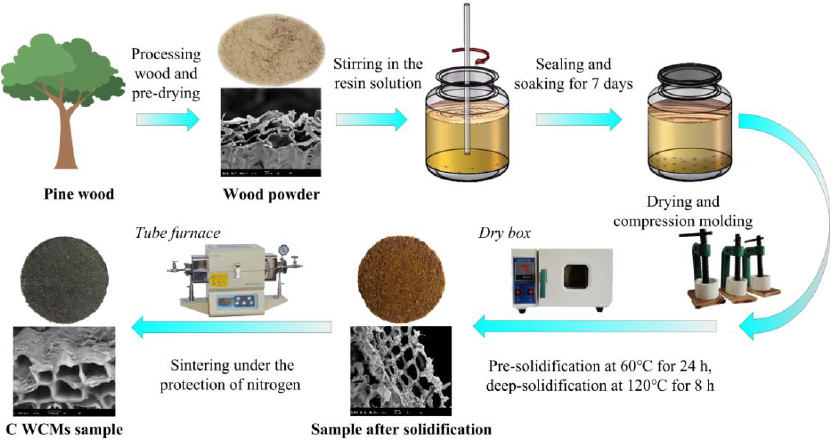
Figure 2. Preparation process route of the C WCMs sample.